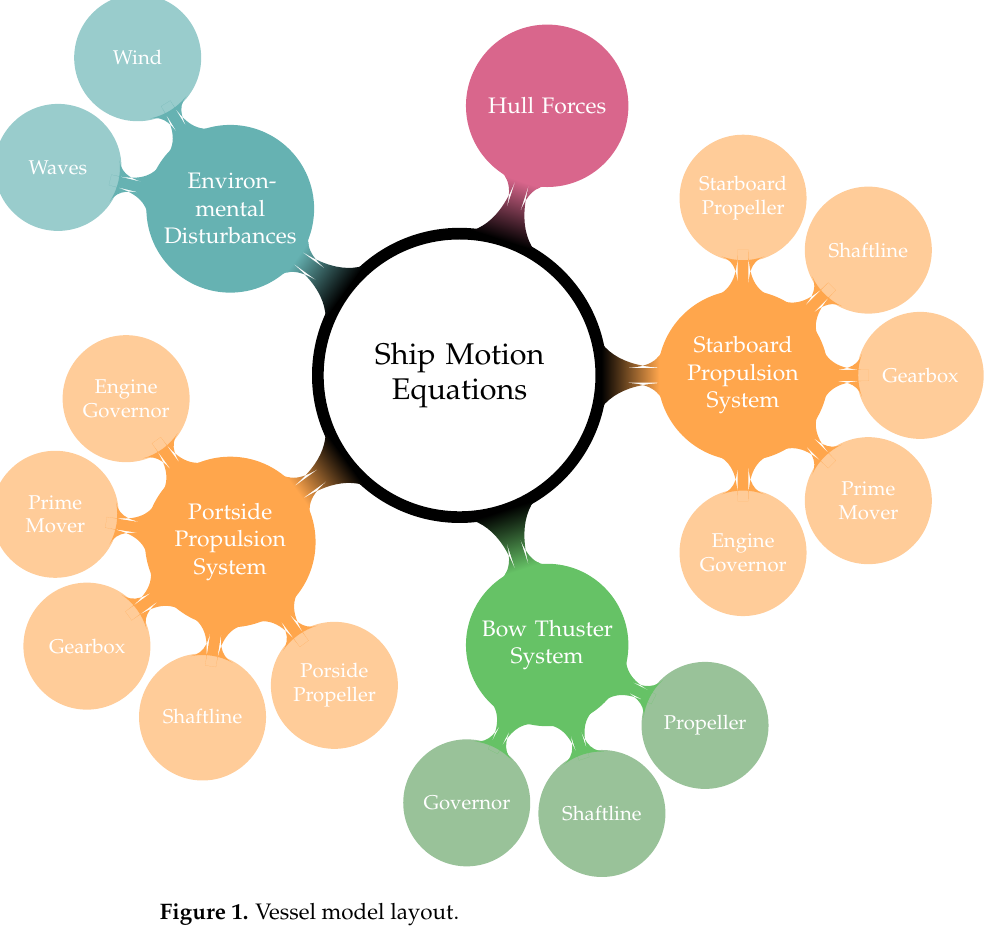
Figure 1. Vessel model